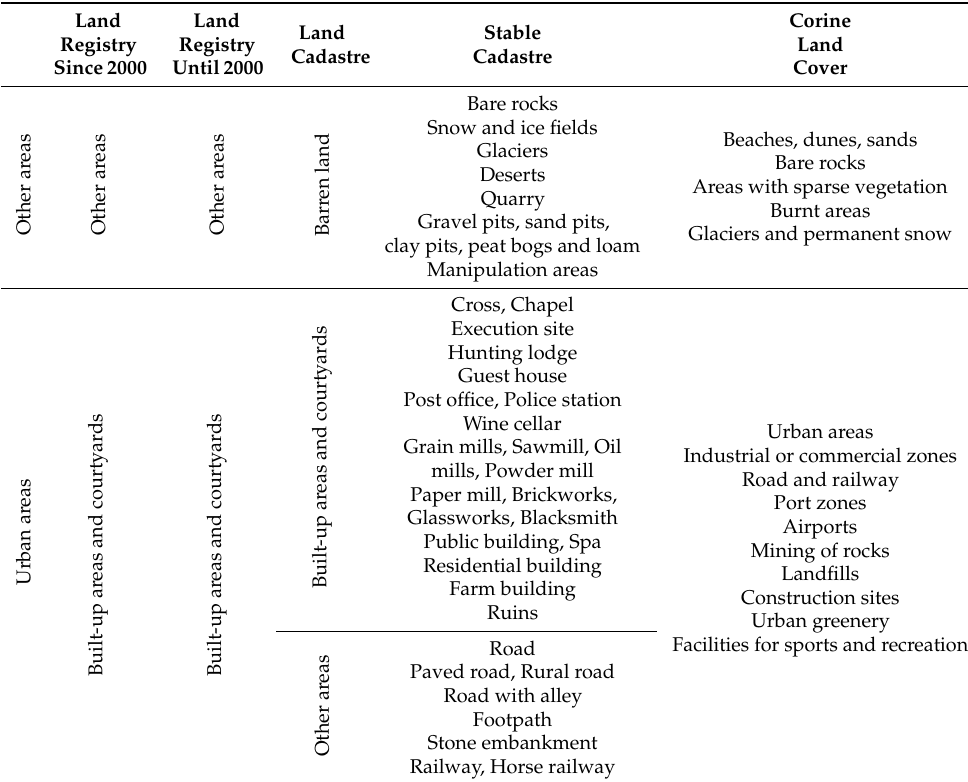
Table A1. Cont. Land Land Land Registry Registry Cadastre Since 2000 Until 2000